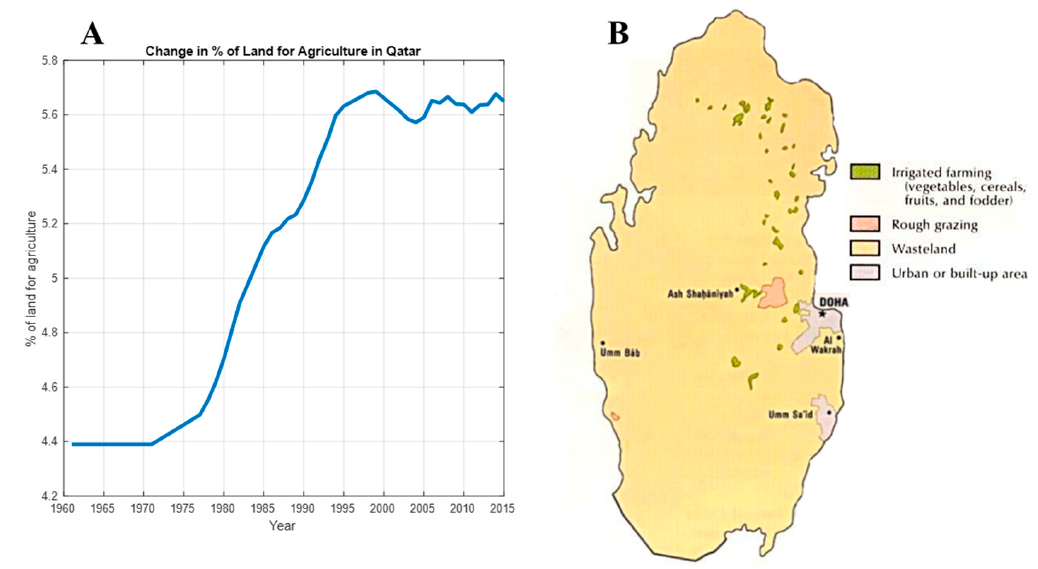
Figure 1. ( A ) Change in % of land for agriculture in Qatar; ( B ) distribution of agricultural land in Qatar.